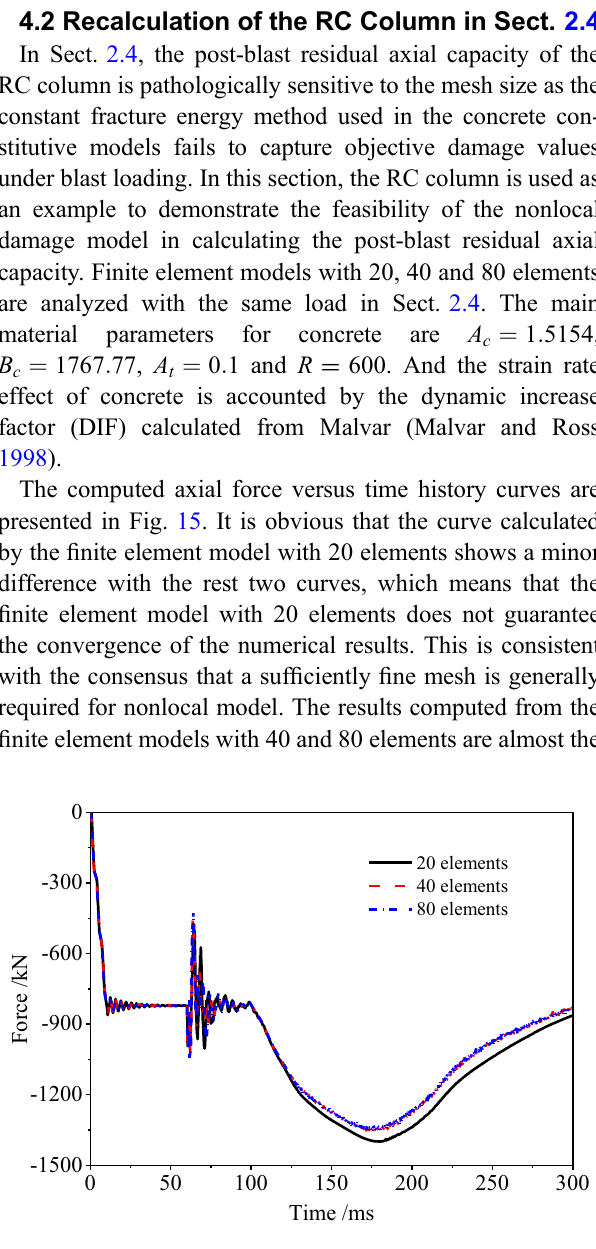
Fig. 15 Comparisons of the axial force time history.